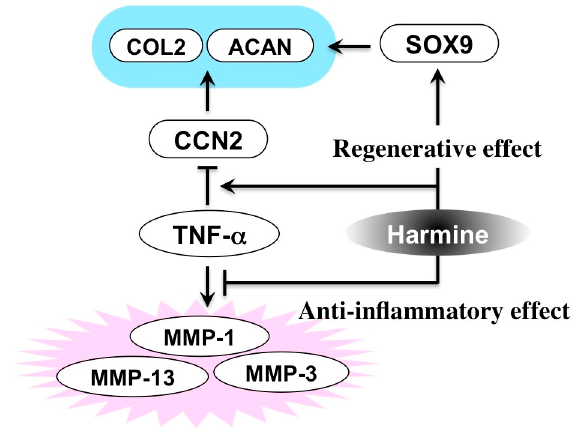
Figure 10. Molecular activity of harmine counteracting the inflammatory degradation of cartilage. COL2, type II collagen; ACAN, aggrecan; MMP, matrix metalloproteinase.